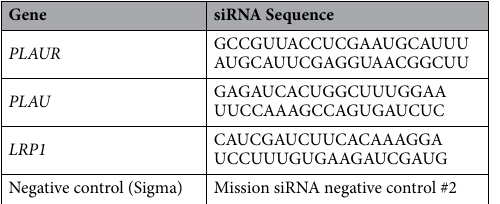
Table 1. Includes the sequence and reference information for the select siRNAs used in the knockdown